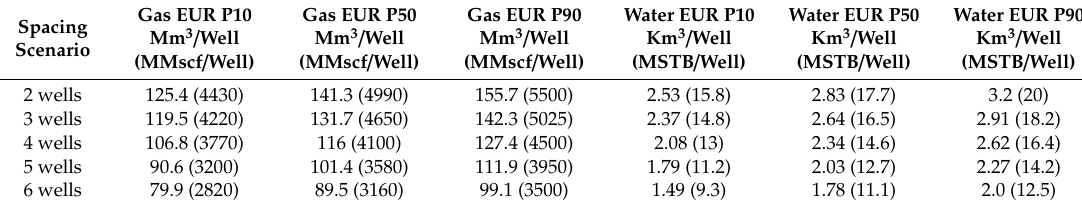
Table 3. Summary of the P10, P50, P90 values of gas and water for 20 years EUR for all five di ff erent spacing scenarios.